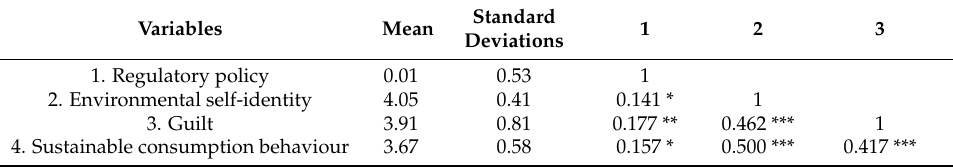
Table 3. Means, standard deviations and correlations.